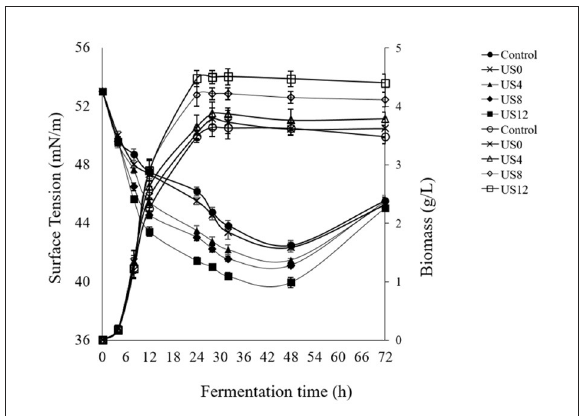
FIGURE2 Effect of ultrasound treatment at different growth stages of L. plantarum (ATCC 8014) on biomass concentration (g/L) and biosurfactant production [surface tension value (mN/m)]. Filled symbols: surface tension values and hollow symbols: biomass concentration.